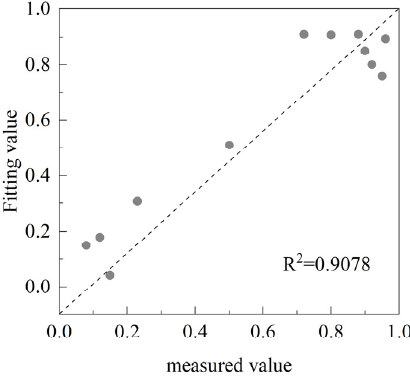
Figure 11. Fitting effect test of the Equation (1).